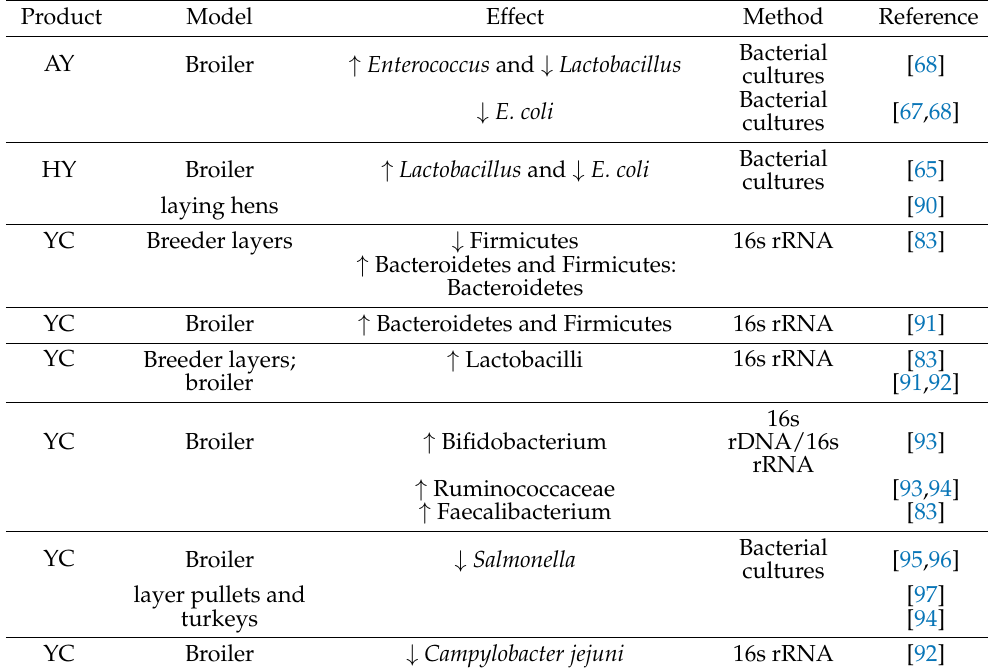
Table 2. Main effects of hydrolyzed-yeast (HY), autolyzed-yeast (AY), and yeast-culture (YC) admin- istration on gut microbiota of